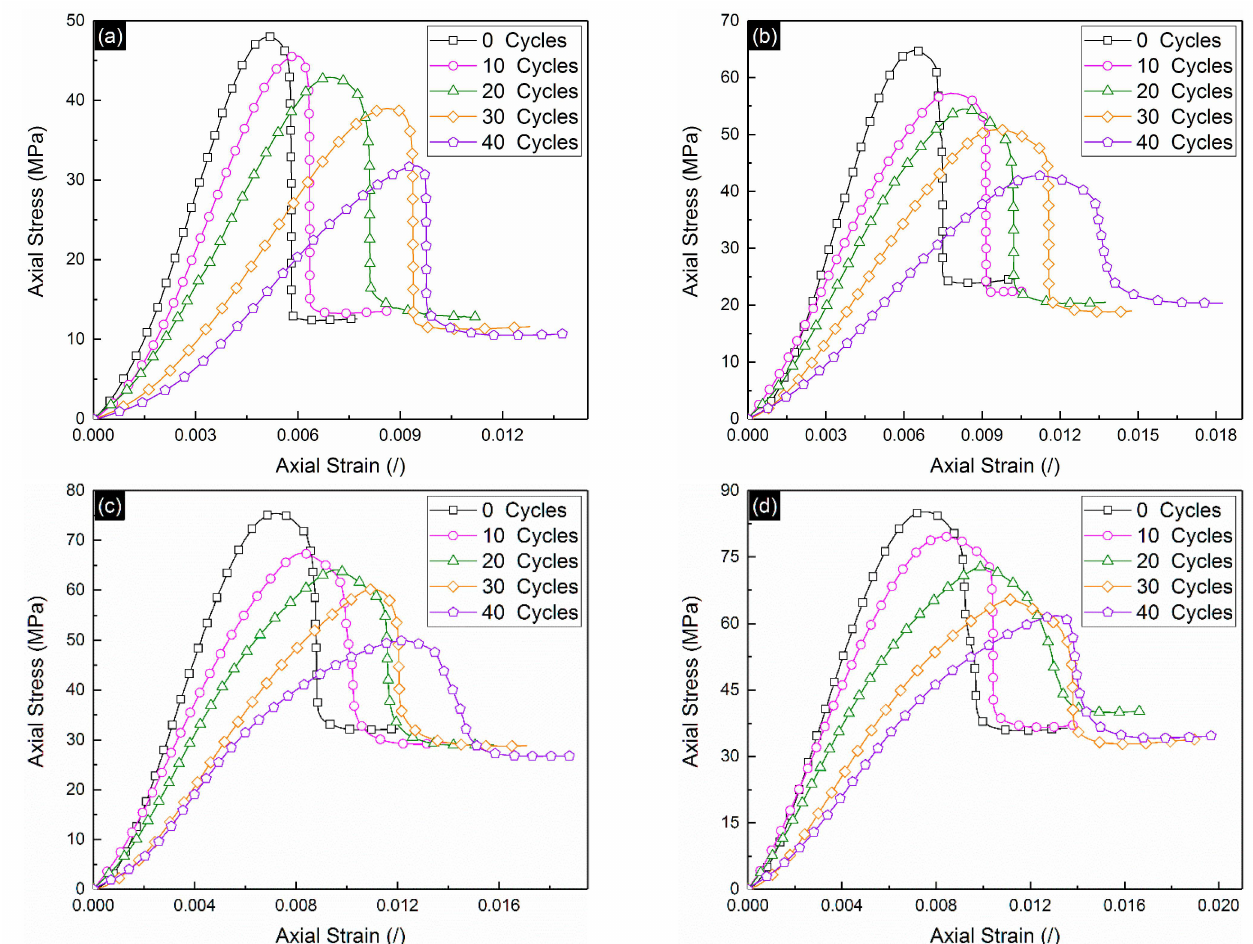
Figure 9. Stress–strain curves of sandstone specimens after undergoing different quantities of F&T weathering cycles under triaxial compression tests: ( a ) 3 MPa; ( b ) 6 MPa; ( c ) 9 MPa; ( d )